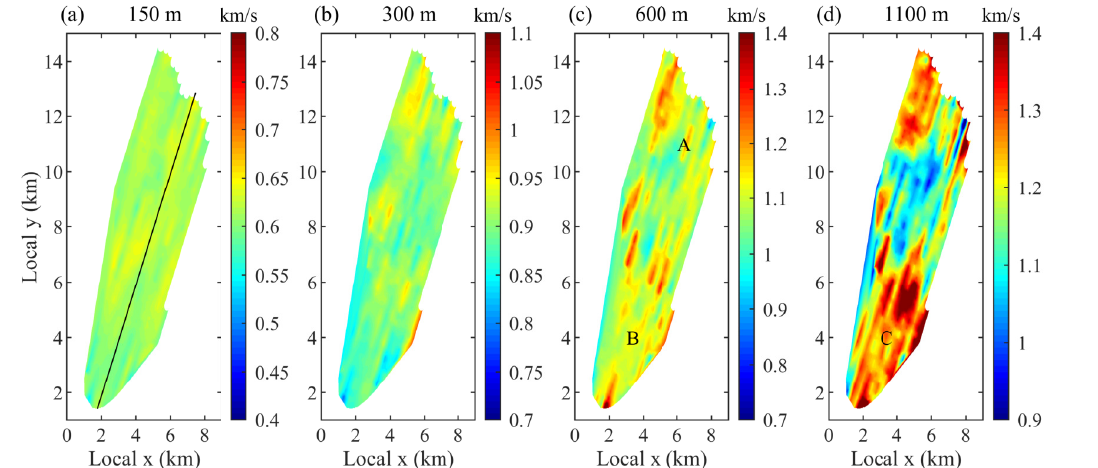
Figure 10. ( a – d ) show horizontal slices of the mean shear-wave subsurface structure at the depth of 150, 300, 600 and 1100 m, respectively. The black line in ( a ) shows the location of Figure 9. The letters in ( c , d ) correspond to the letters in Figure